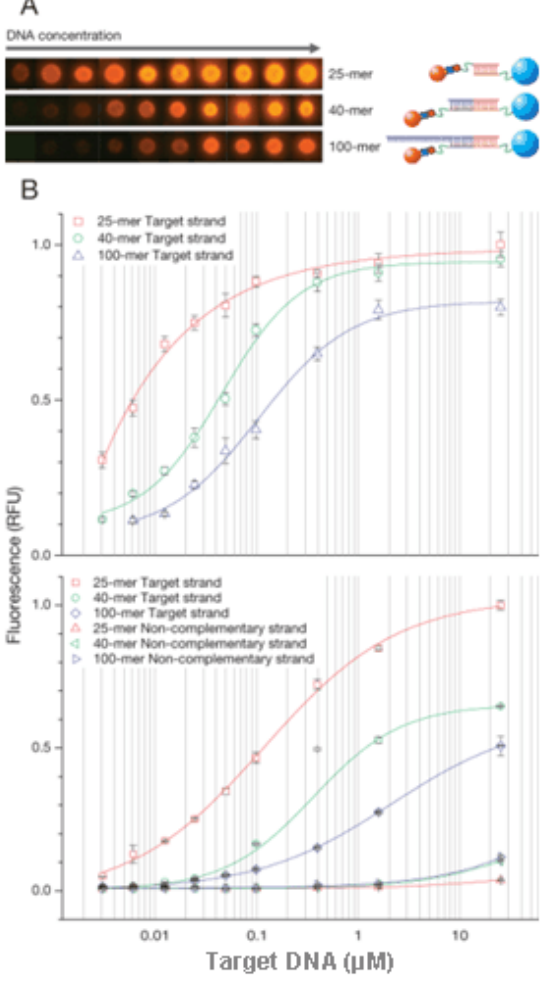
Figure 4. A. Fluorescence images of MPs after hybridization with target DNA of varying length (25-, 40-, 100-mer) and QD probes. B. The hybridization complexes were characterized and quantified by fluorescence microscopy (upper panel) and flow cytometry (bottom panel). Fluorescence intensity is plotted as a function of concentration of the target